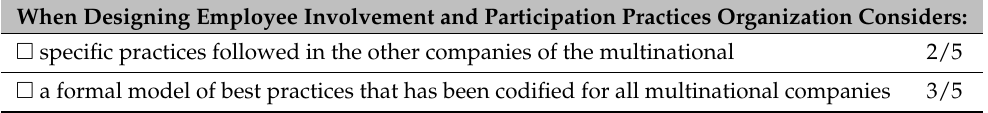
Table 3. The Design of employee involvement and participation practices.